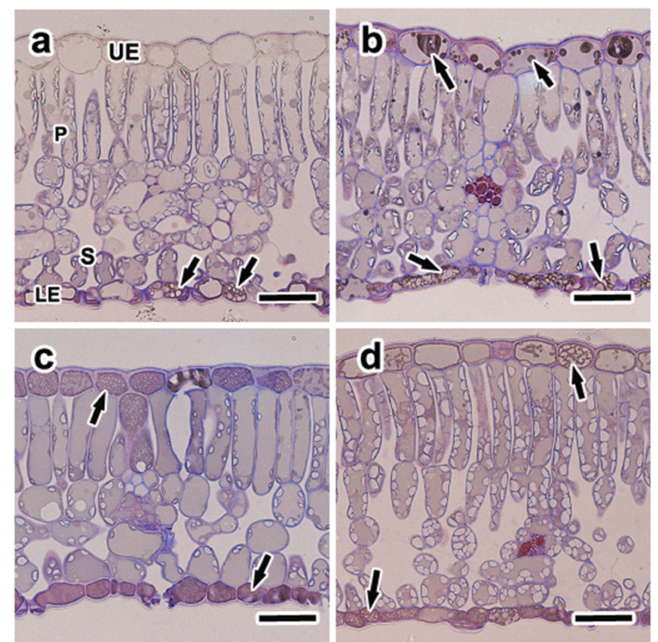
Figure 6. Micrographs of the cross sections of oak ( Quercus mongolica ) leaves in all treatments. These sections were double-stained with safranin and gentian violet. ( a ) Ambient CO 2 and low nitrogen, ( b ) ambient CO 2 and high nitrogen, ( c ) elevated CO 2 and low nitrogen, and ( d ) elevated CO 2 and high nitrogen. The arrows indicate phenolic compounds. LE; lower epidermis, P; palisade layer, S; spongy parenchyma, UE; upper epidermis, scale bars = 20 µ